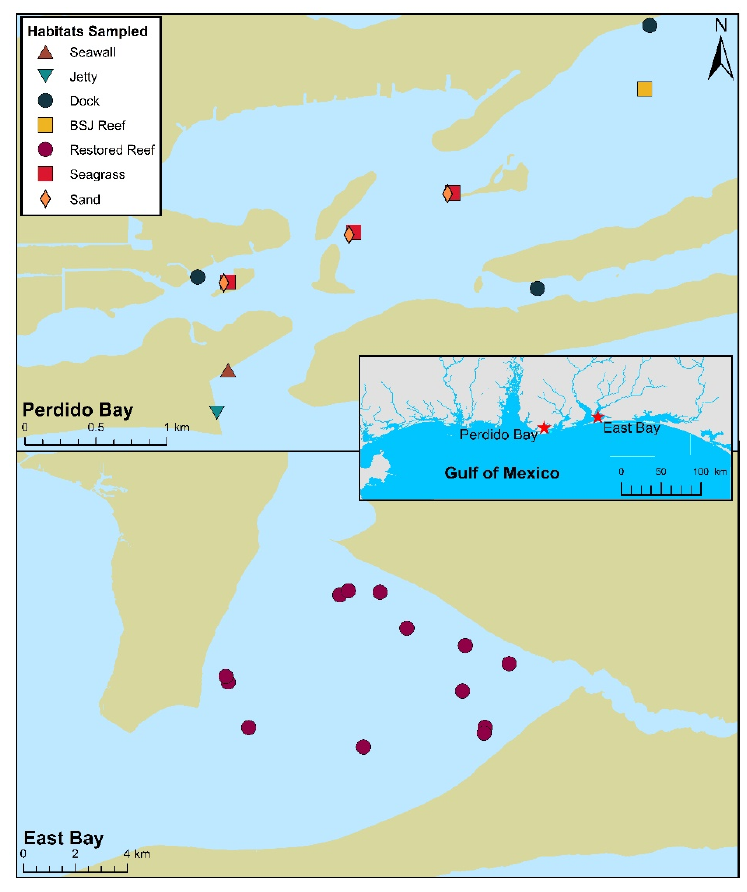
Figure 1. Perdido and East Bays in the central northern Gulf of Mexico, showing the natural and artificial habitats sampled with underwater videos. Symbol colors and shapes indicated in the legend are consistent for all following